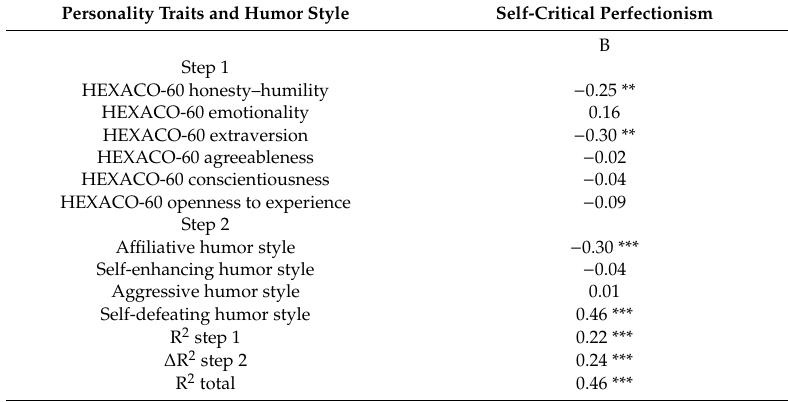
Table 3. The contributions of personality traits HEXACO-60 (first step) and Humor Styles (second step) to self-critical perfectionism.